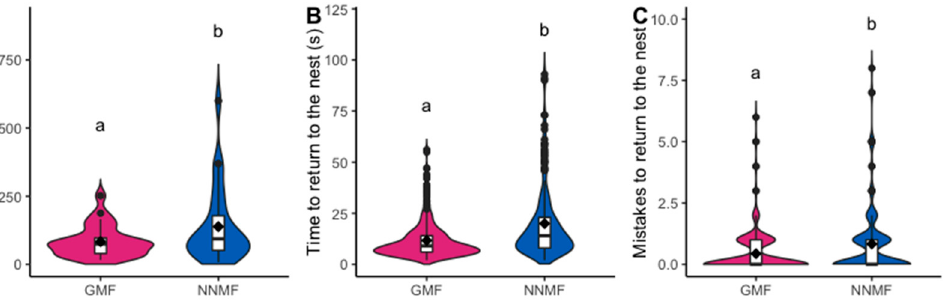
Figure 2. Foraging activity of Lasius niger under GMF and NNMF recorded during Phase 2. Violin plots show ( A ) the time spent by the first recruited worker to reach the food source, ( B ) the time to return to the nest by all workers that had fed for more than 30 seconds at the food source, and ( C ) the number of errors made while returning to the nest. The violin shape shows the distribution of the values, and the box plot is made by a black line in the center that indicates the median; the top and bottom of the black box represent the upper and lower quartiles; whiskers represent the maximum and minimum values, while the black dots indicate the outliers. Diamonds indicate mean values. Different letters indicate significantly ( p < 0.05) different values based on generalized linear mixed model results.